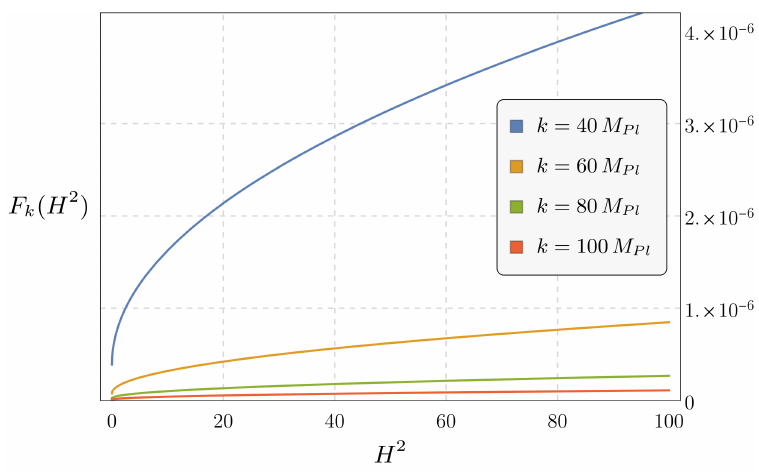
Figure 3 . The function F k ( H 2 ) for c 0 = c 1 = 1 and various values of the RG scale k , in units of the Planck mass, in d = 3 space dimensions.